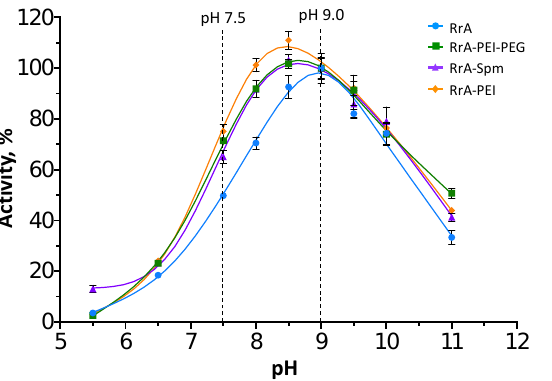
Figure 6. pH dependence of activity for native RrA and its conjugates: 5 mM citrate phosphate–borate buffer, 37 ◦ C. Both the native enzyme and the conjugates have a typical bell-shaped dependence with a maximum pH of 8.5 – 9.0. The conjugates RrA-PEI, RrA-PEI-PEG, and RrA-Spm have a 0.5-unit shift to a more acidic region compared to the native enzyme. At a pH of 7.5, the activity of the conjugates increases by 13 – 22% compared to the native enzyme. As in the PBS, the RrA-PEI-PEG conjugate was most active at a pH of 7.5 in the citrate phosphate – borate buffer (CPBB). The native enzyme had an activity of 60 IU/mg at a pH of 7.5 in the CPBB. RrA-PEI-PEG, RrA-Spm, and RrA-PEI had an activity of 74, 71, and 68 IU/mg, respectively. At the same time, the activity of RrA and its modified